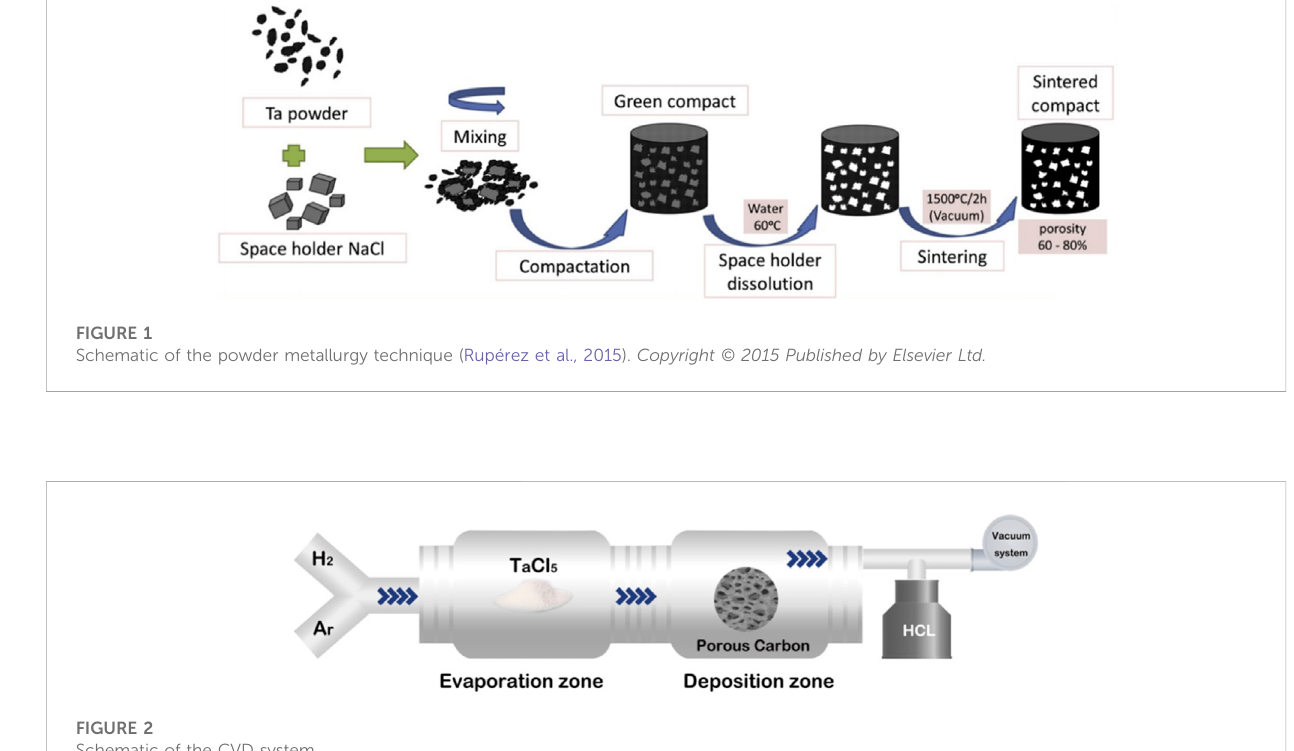
Schematic of the CVD